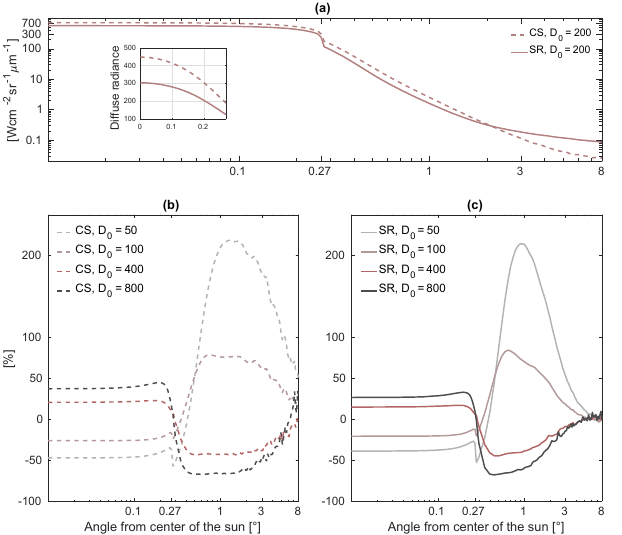
Figure 8. Impact of ice crystal size distribution on the disk and cir- cumsolar radiances. (a) shows, for reference, the radiances for a log- normal size distribution with a median diameter D 0 = 200µm for smooth (CS) and severely rough (SR) ice crystals. (b) and (c) show the relative differences to the case with D 0 = 200µm for D 0 = 50, 100, 400, and 800µm. In these simulations, τ a = 0 . 09 and τ c = 1 . 6.